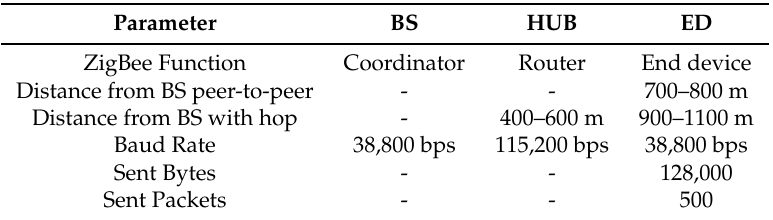
Table 6. Scenario 2: Configuration and position